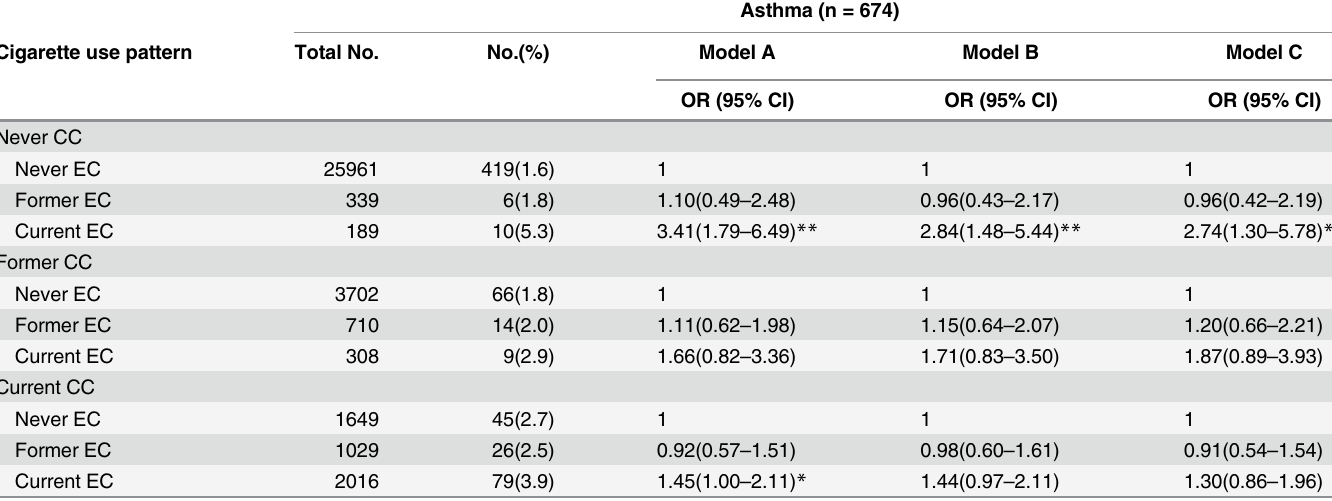
Table 6. Results of multiple logistic regression analyses of dependent variables with asthma among high school students in Korea.